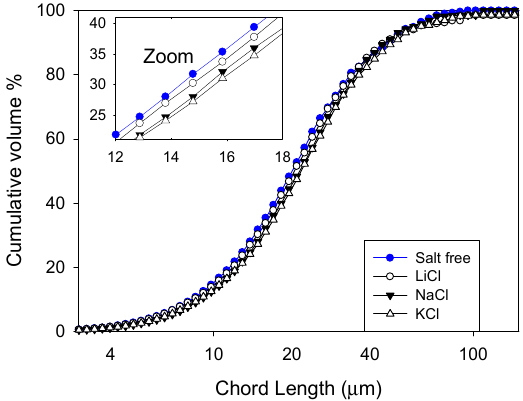
Figure 9. Effect of the type of salt (0.01 M) on cumulative volume distribution. Pulps are formulated at 10% by weight and natural pH. The mean sqrt size for each system is ( i ) salt-free: 24.1 µm, ( ii ) LiCl: 25.4 µm, ( iii ) NaCl: 26.3 µm, and ( iv ) KCl: 27.1 µm.